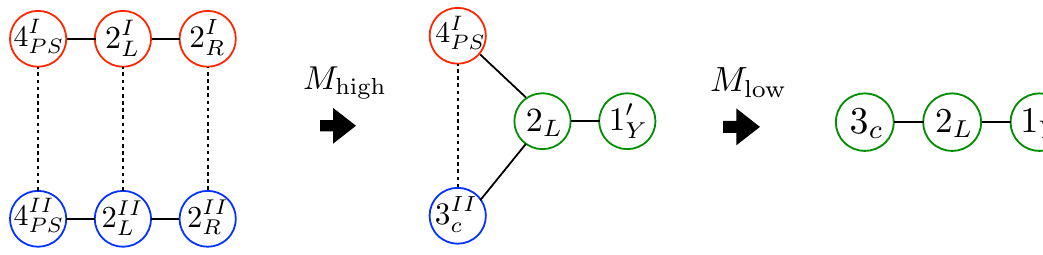
Figure 1 . The model is based on two copies of the PS gauge group SU(4) PS × SU(2) L × SU(2) R . The circles represent the gauge groups with the indicated symmetry breaking as in eq.